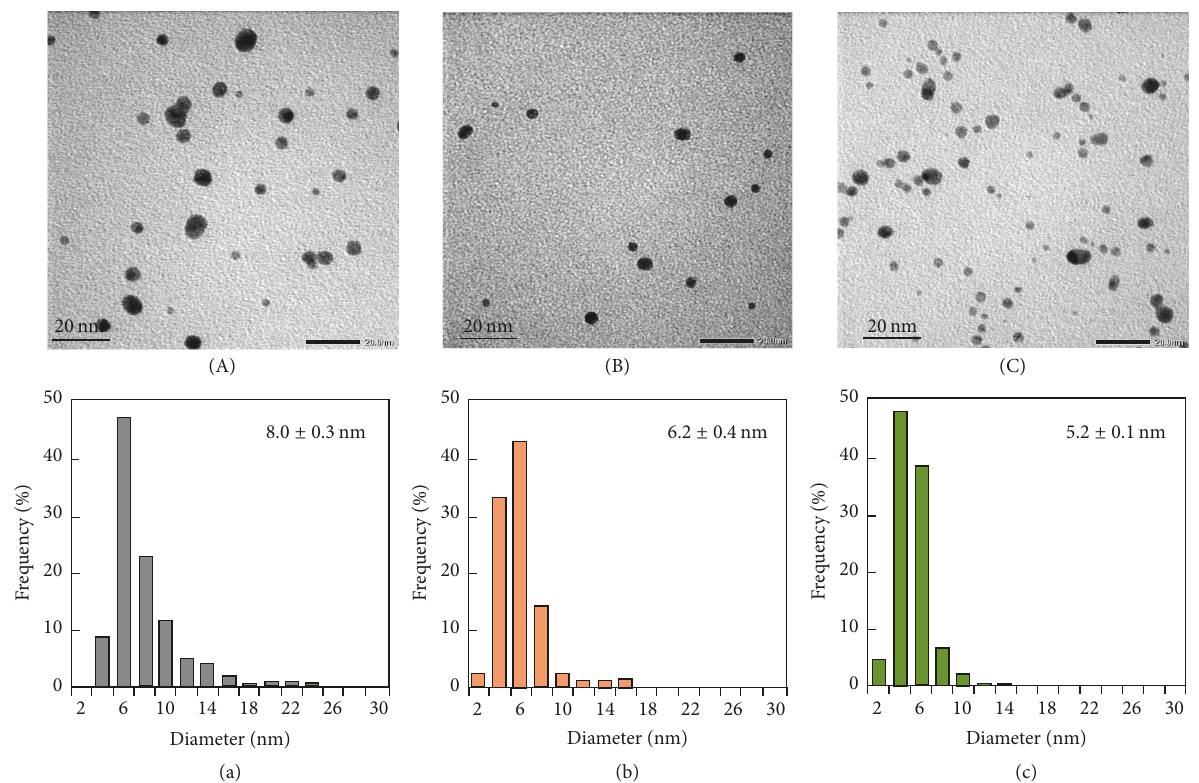
Figure 6: TEM images and size distribution histogram of AuNPs/dextran at different dextran concentrations: 0.5 (A, a), 1.0 (B, b), and 2.0% (C, c).